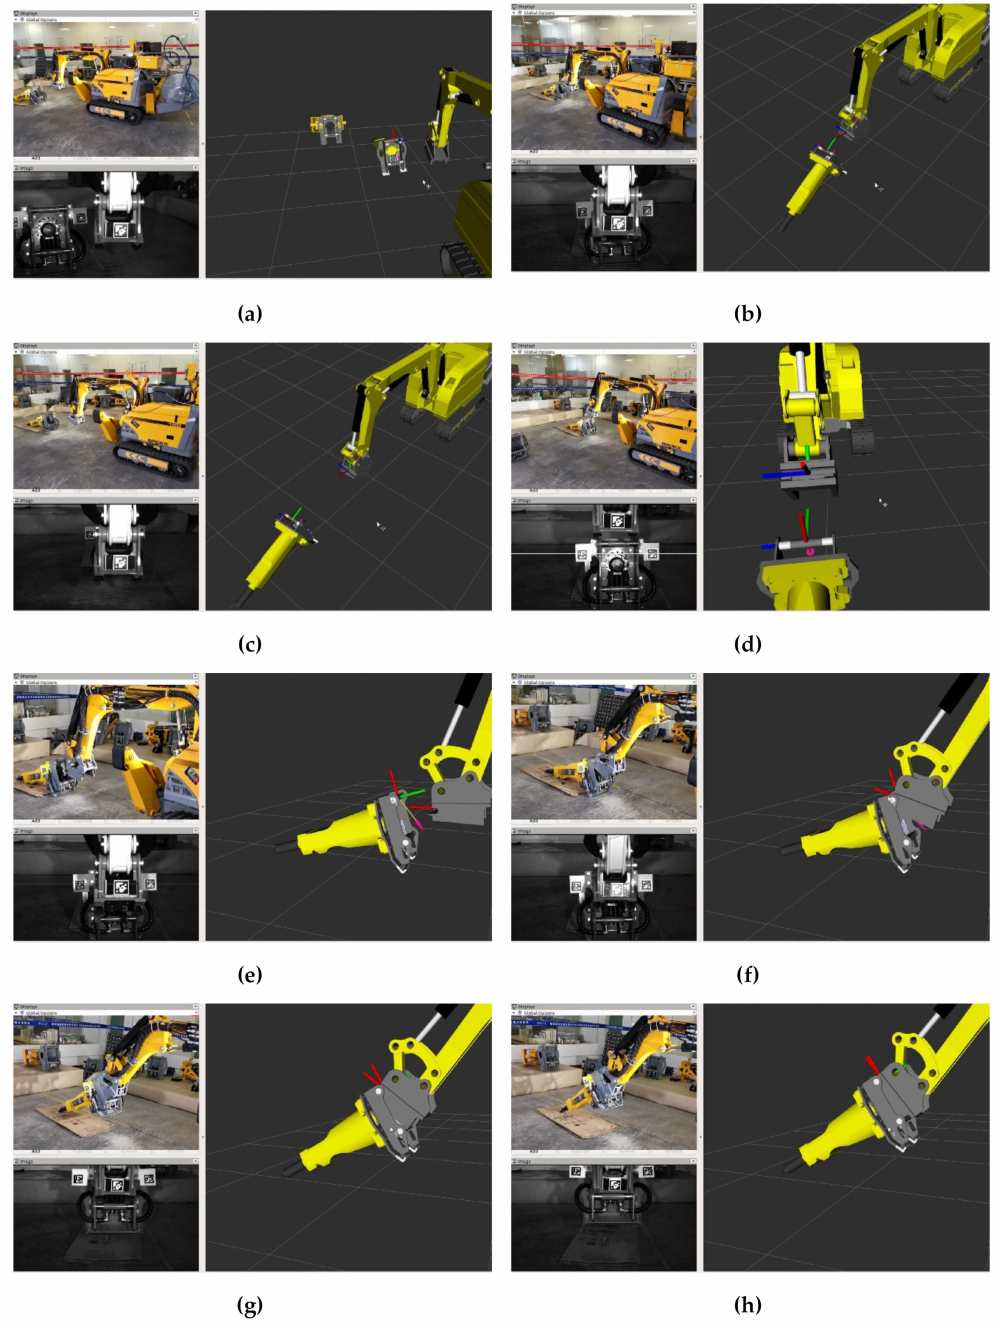
Figure 10. Experiment of attachment changing without trajectory planning. ( a ) ( b ) ( c ) and ( d ) Initialization stage. ( e ) Preparation stage. ( f ) Range alignment stage. ( g ) and ( h ) Angle alignment